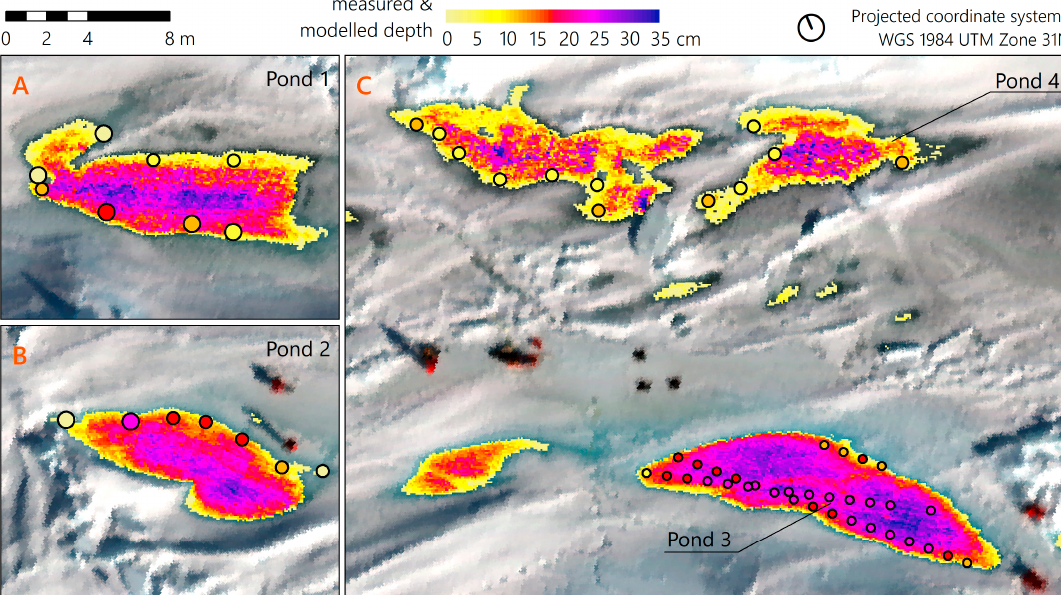
Figure 11. Results of pond depth model applied to empirical line correction results. Modelled and measured depth share the same color code. Circle sizes correspond to estimated spatial uncertainties (radii are 20 cm, 30 cm and 40 cm). ( A ) Pond 1. ( B ) Pond 2. ( C ) Ponds 3 and 4. Background: AisaEAGLE flight stripe (spatial resolution: 8.5 cm, RGB: 661.16 nm, 550.25 nm, and 482.57 nm).